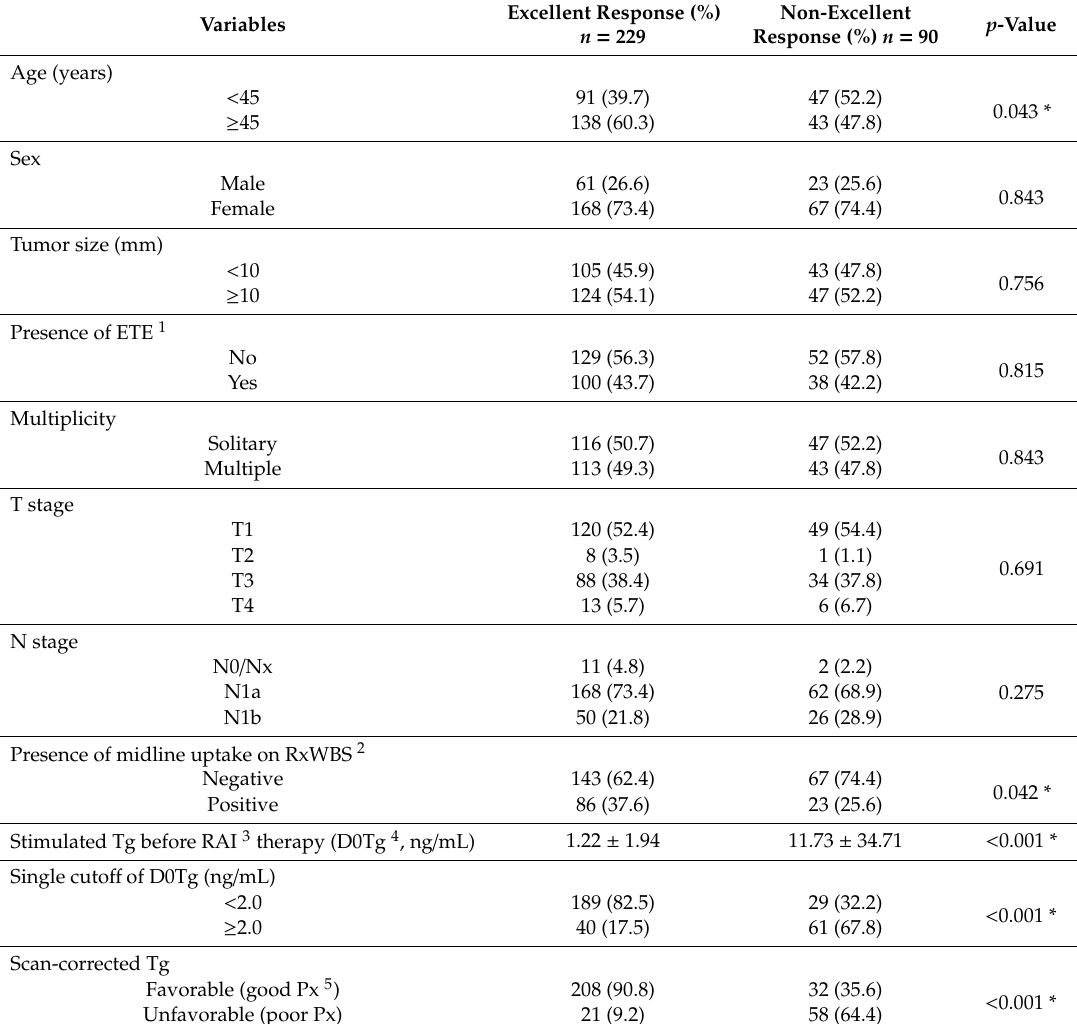
Table 2. Univariate analysis of clinicopathologic variables for prediction of the therapeutic